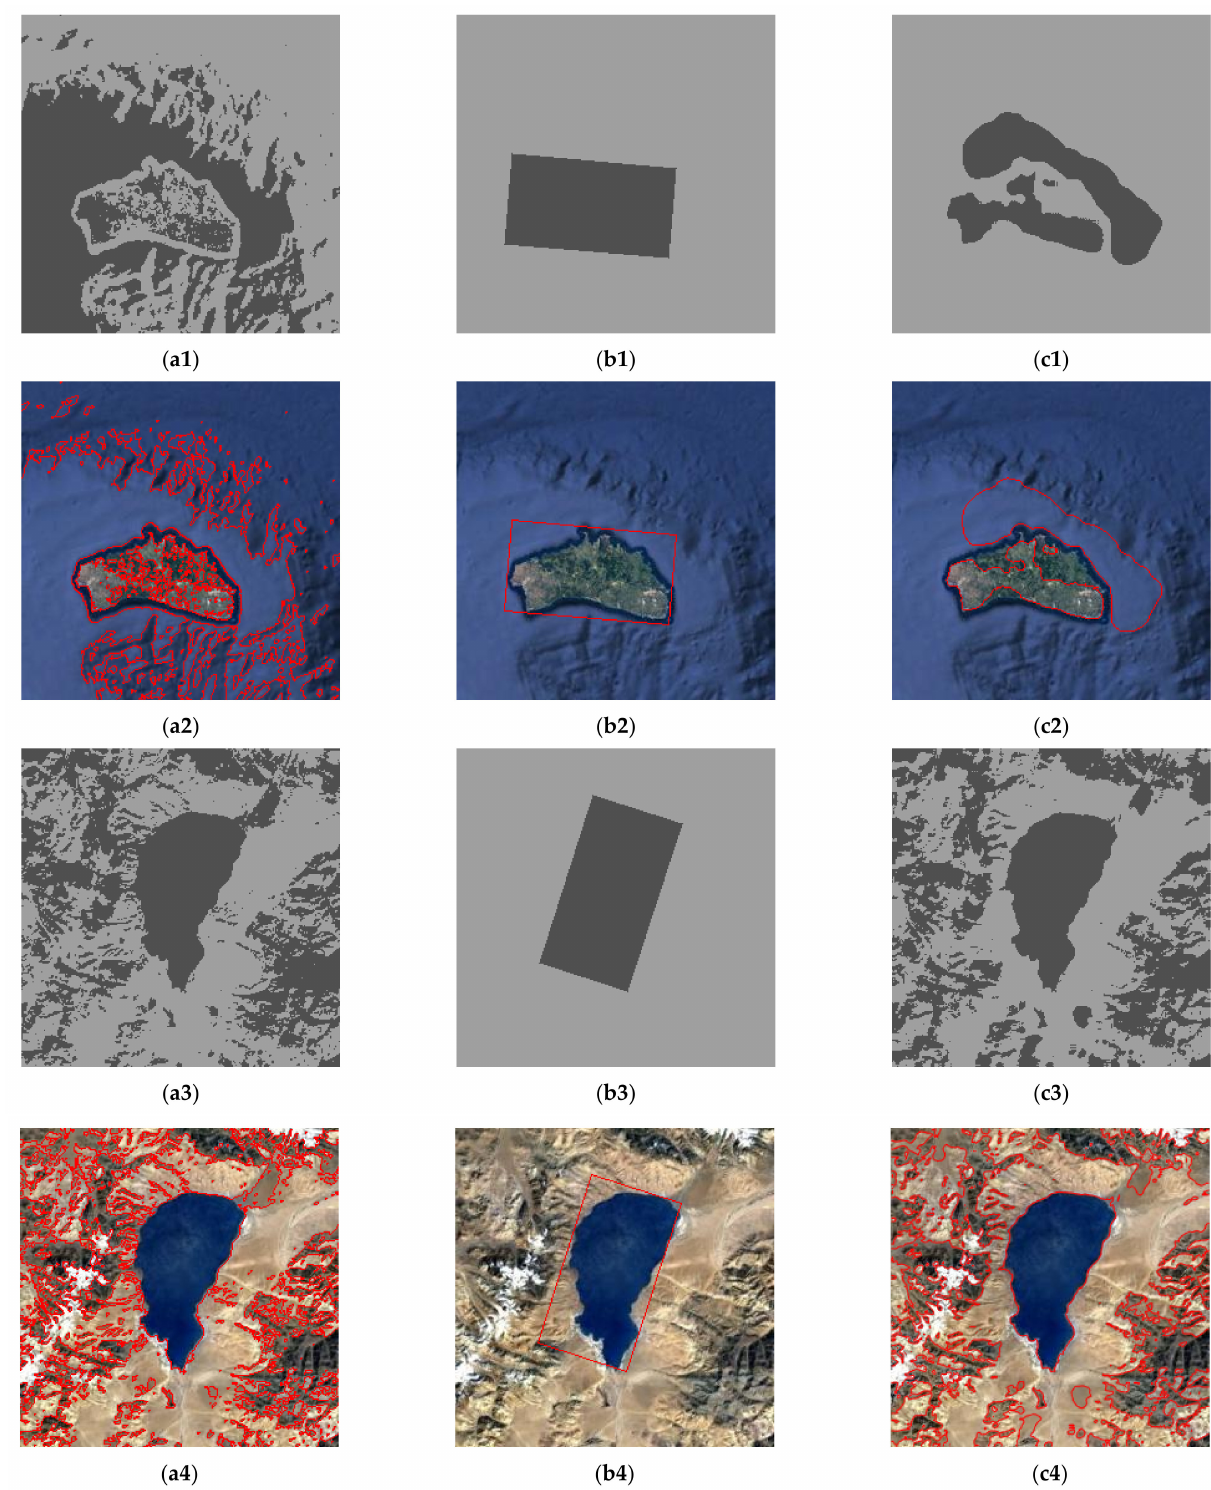
Figure 12. Experimental results of comparison algorithm: ( a1 ) Pixel based island segmentation; ( b1 ) Rule mark island segmentation; ( c1 ) Active contour island segmentation; ( a2 ) Pixel based island extraction; ( b2 ) Rule mark island extraction; ( c2 ) Active contour island extraction; ( a3 ) Pixel-based lake segmentation; ( b3 ) Rule mark lake segmentation; ( c3 ) Active contour lake segmentation; ( a4 ) Pixel based lake extraction; ( b4 ) Rule mark lake extraction; ( c4 ) Active contour lake